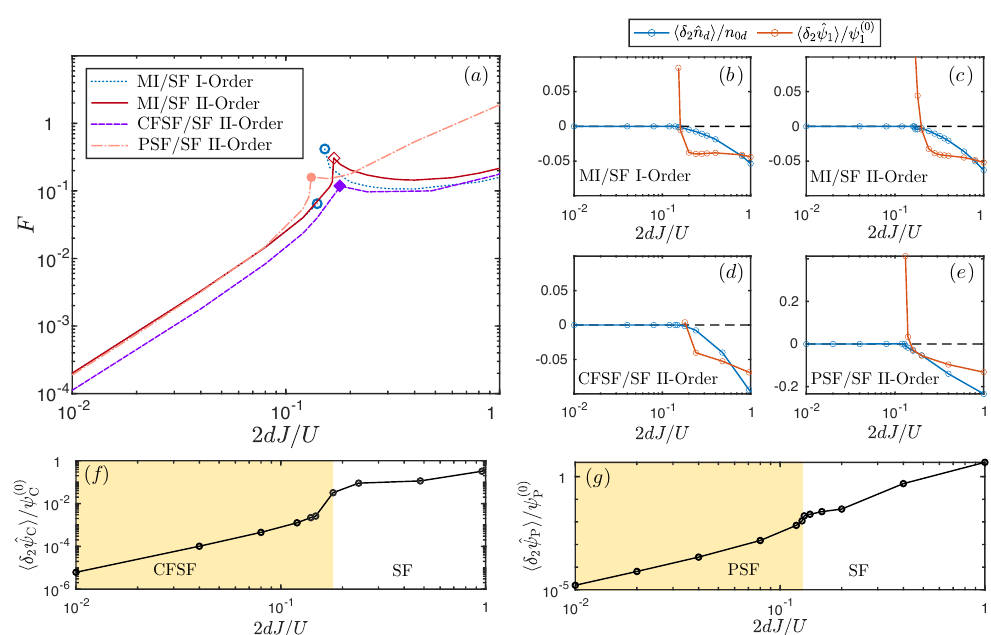
Figure 17: (a) Control parameter F as defined in Eq. (A.26) plotted in two dimen- sions as a function of 2 d J / U for fixed n corresponding to the transitions shown in 0, d the right panel. The point located on each curve indicates the location of the respec- tive phase transition. (b)-(d) Quantum corrections to the order parameters and total density for the transitions considered in the (a). (b) First-order MI-to-SF transition / U = 0.9 and n = 2. (c) Second-order MI-to-SF transition for U / U = 0.5 for U d 12 12 = 2. (d) CFSF-to-SF transition for U / U = 0.9 and n = 1. (e) PSF-to-SF and n d d 12 / U = − 0.7 and n ≈ 1.47. (f) Quantum corrections to the CFSF or- transition for U d 12 = 1 at U / U = 0.9 and along the µ/ U = 0.5 der parameter for fixed total density n d 12 line within the CFSF phase. (g) Quantum corrections to the PSF order parameter for ≈ 1.47 at U / U = − 0.7 and along the ( µ/ U ) = − 0.35 critical fixed total density n d c 12 line within the PSF